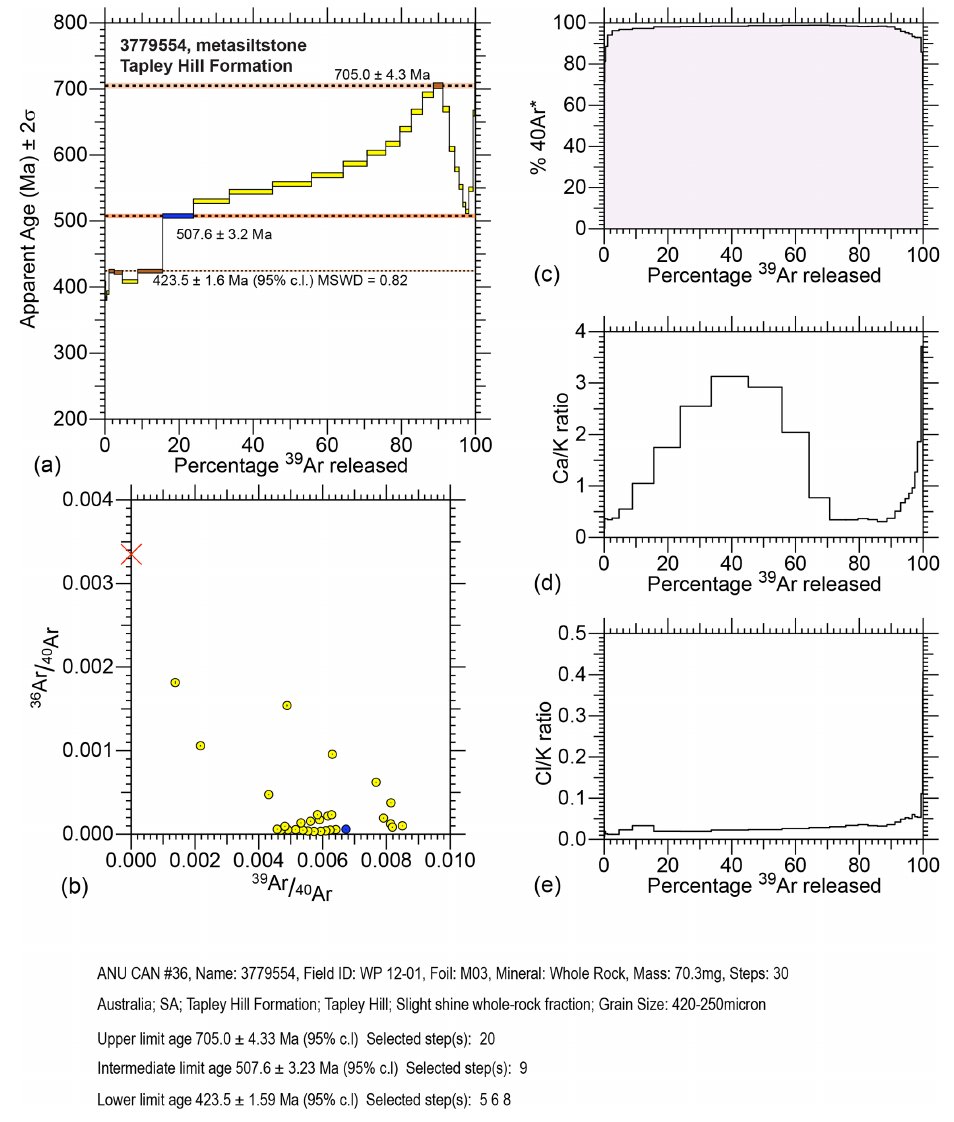
Figure C5. Sample 3779554 (a) age spectrum, (b) isotope correlation diagram, (c) percentage radiogenic 40 Ar ( 40 Ar ∗ ), (d) Ca / K ratio, and (e) Cl / K